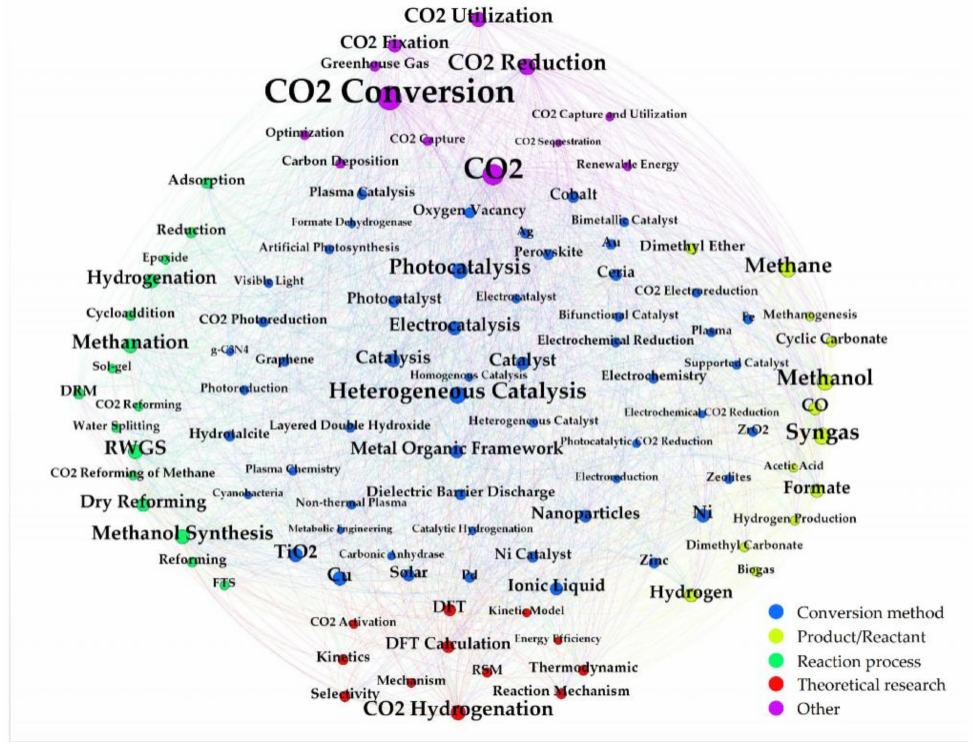
Figure 4. Classification map of the top 108 keywords (Frequency >